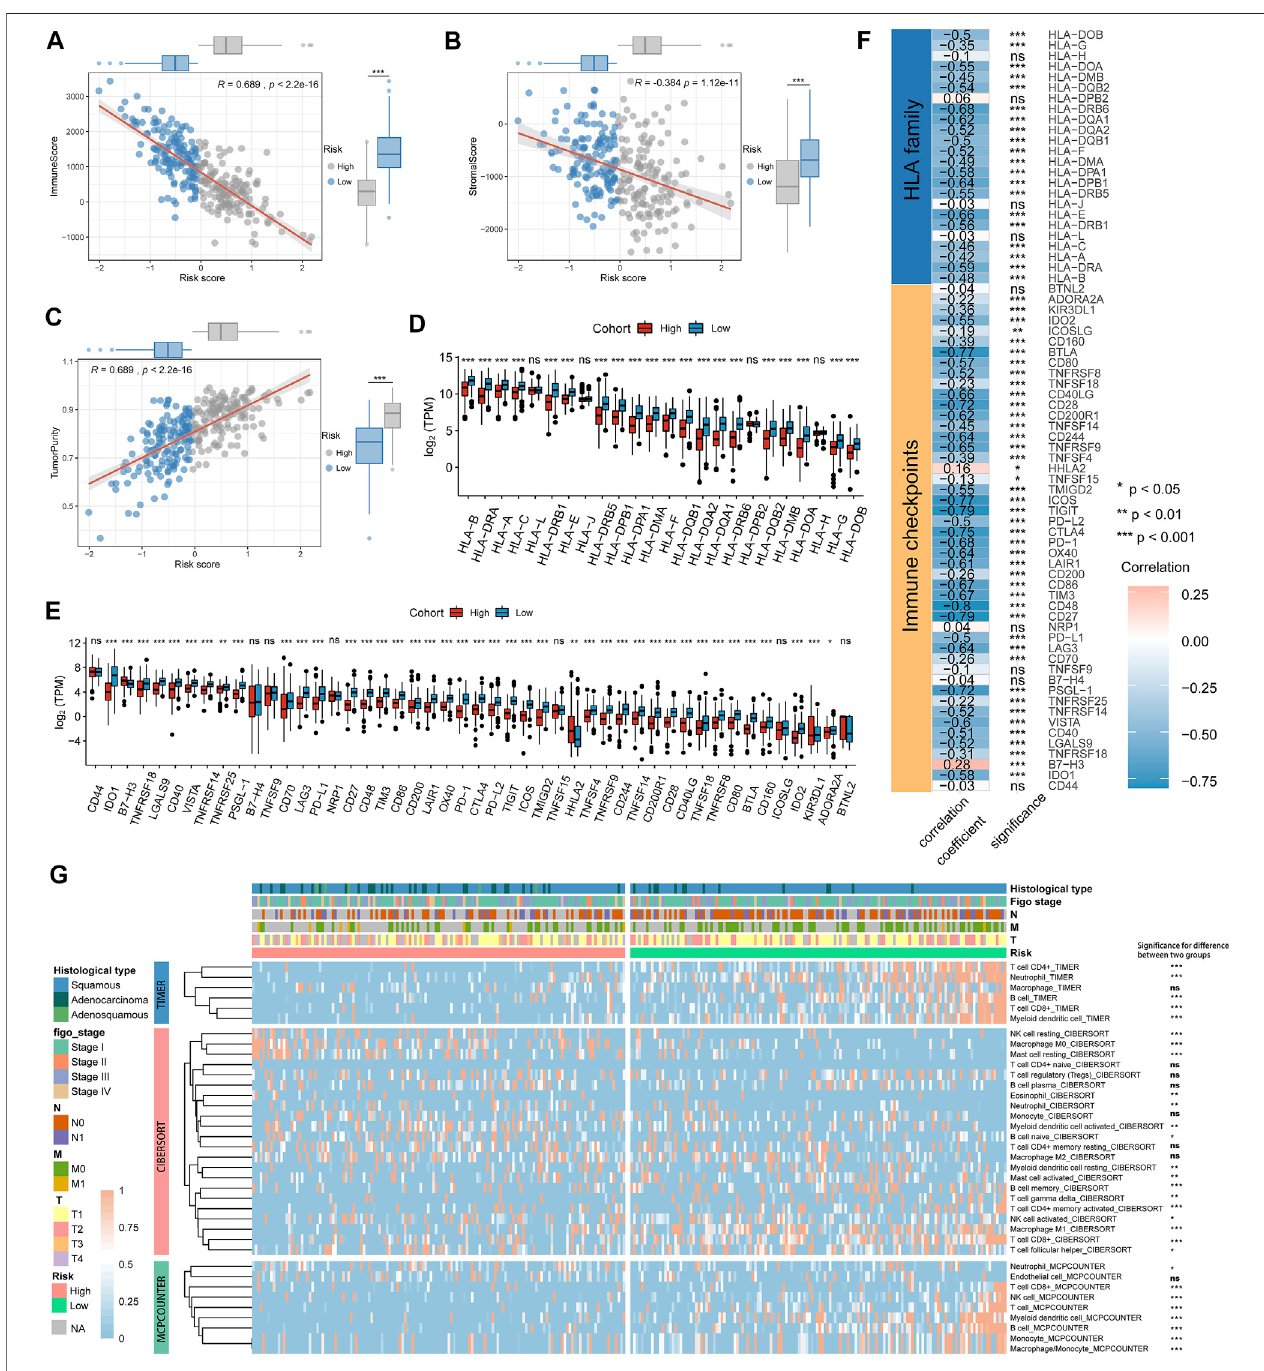
FIGURE 5 | The immune signature between the high- and low-risk groups in the TCGA cohort. (A – C) Association between immune score, stromal score, tumor purity, and risk score and their distribution in different risk groups. (D,E) Differential analysis of gene expression levels of HLA family genes and immune checkpoints in different risk groups. (F) Correlation analysis for the risk score and the gene expression levels of HLA family genes and immune checkpoints. (G) The heatmap showing the immune and stromal cell in fi ltration levels and differences in distribution between different risk groups. * p < 0.05; ** p < 0.01; *** p < 0.001; ns, not signi fi cant.